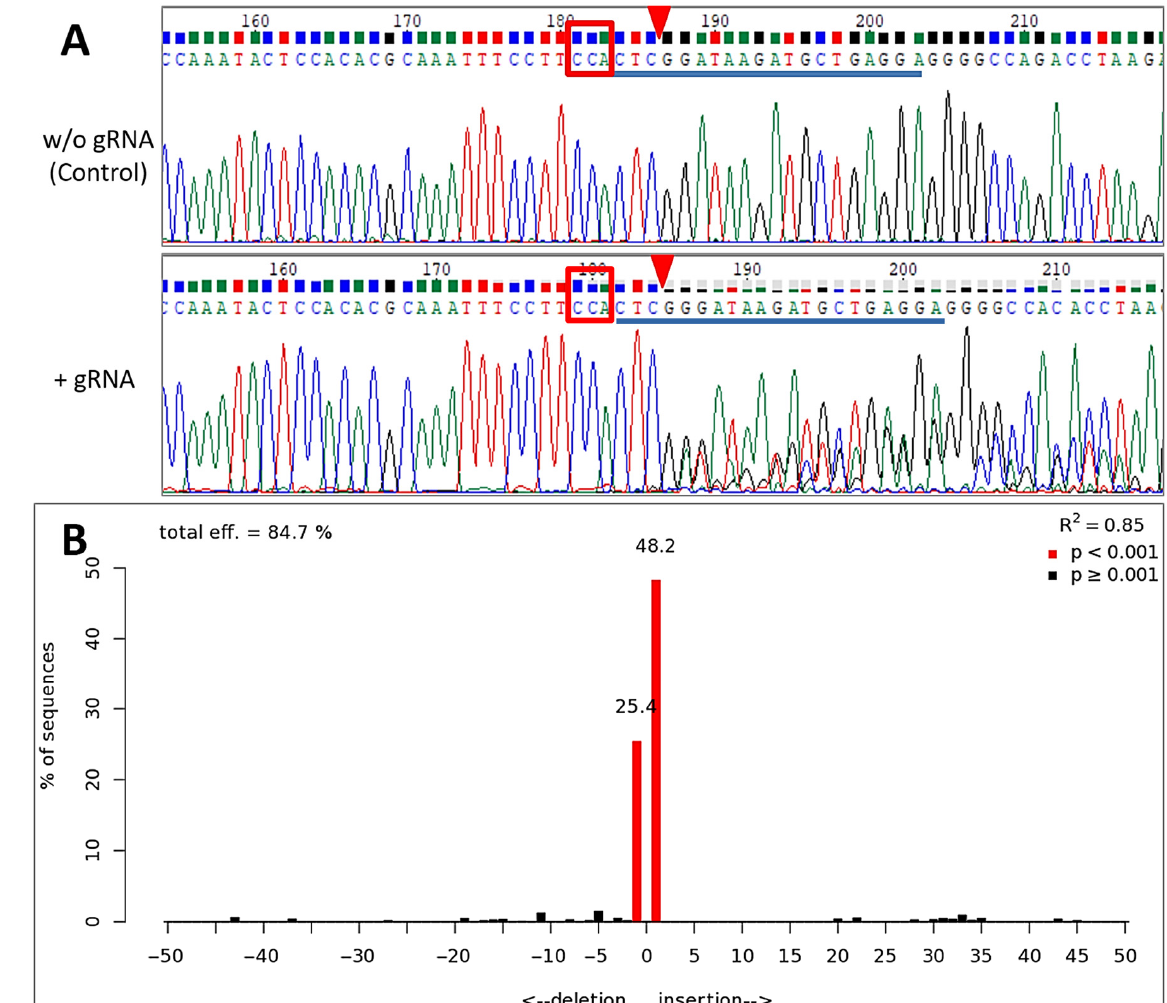
Figure 6. Results of TP53 gene sequencing within the range of genome editing in HEK293T cells after induction of Cas9 programmable nuclease expression. ( A ) An alignment of TP53 allele sequences within the range of genome editing; the blue line labels the gRNA binding region, the red frame marks the PAM sequence and the red triangle marks the Cas9 cleavage region. ( B ) The result from the analysis of the sequencing data in the TIDE